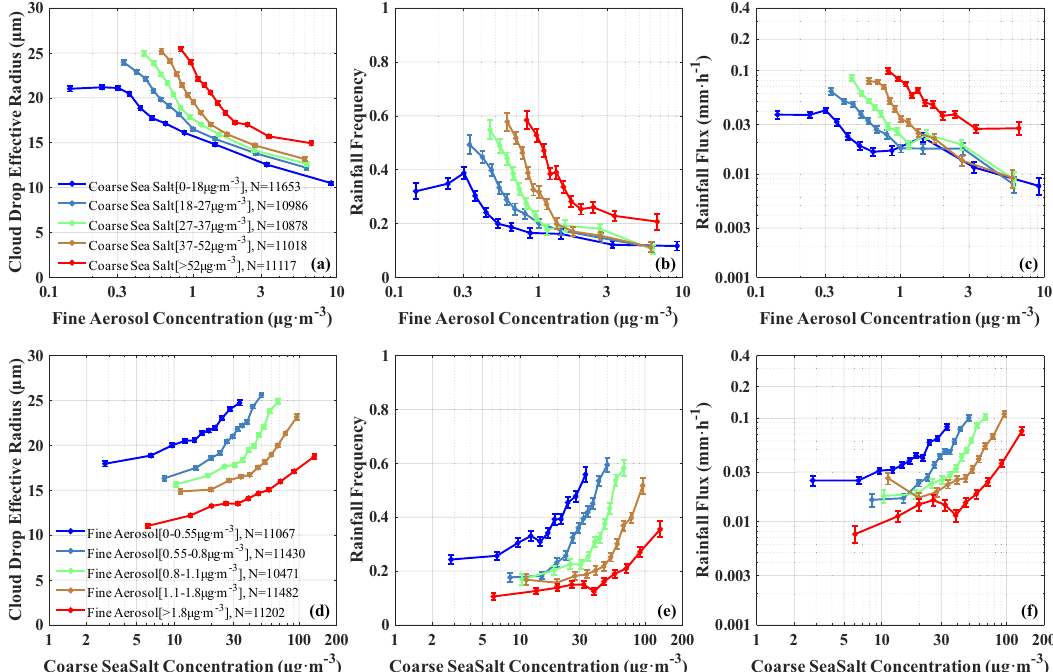
Fig. 3 Aerosol-driven cloud drop effective radius ( r e ) and rainfall variations for fi ne aerosol (top) and coarse sea spray aerosols (CSA) (bottom) concentrations at the constant bins of another aerosol type. Shown are a r e , b rainfall frequency, and c rainfall fl ux (including both rainfall and non-rainfall cases) driven by fi ne aerosol. The d – f are the same as a – c , but for CSA. The quantiles of the average for the 11 aerosol bins and vertical error bars are the same as in Fig.